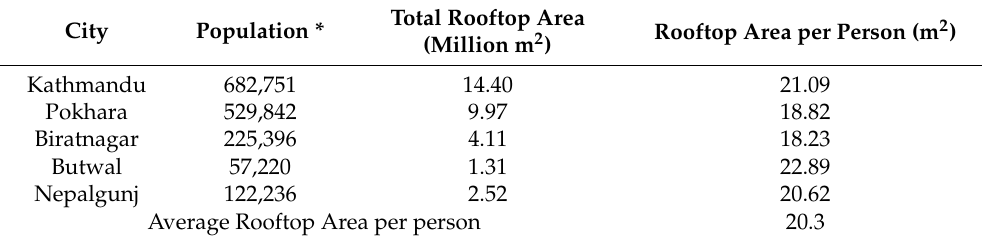
Table 4. City and rooftop area.